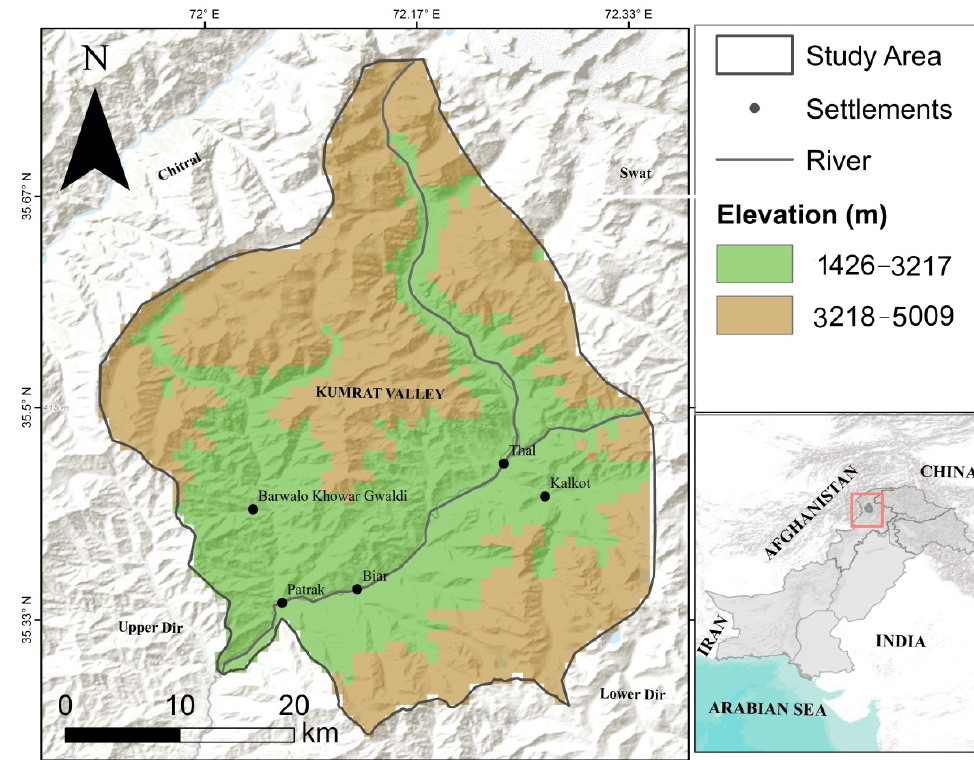
Figure 1. Study area map depicting Kumrat Valley and the surveyed settlements in the current study .